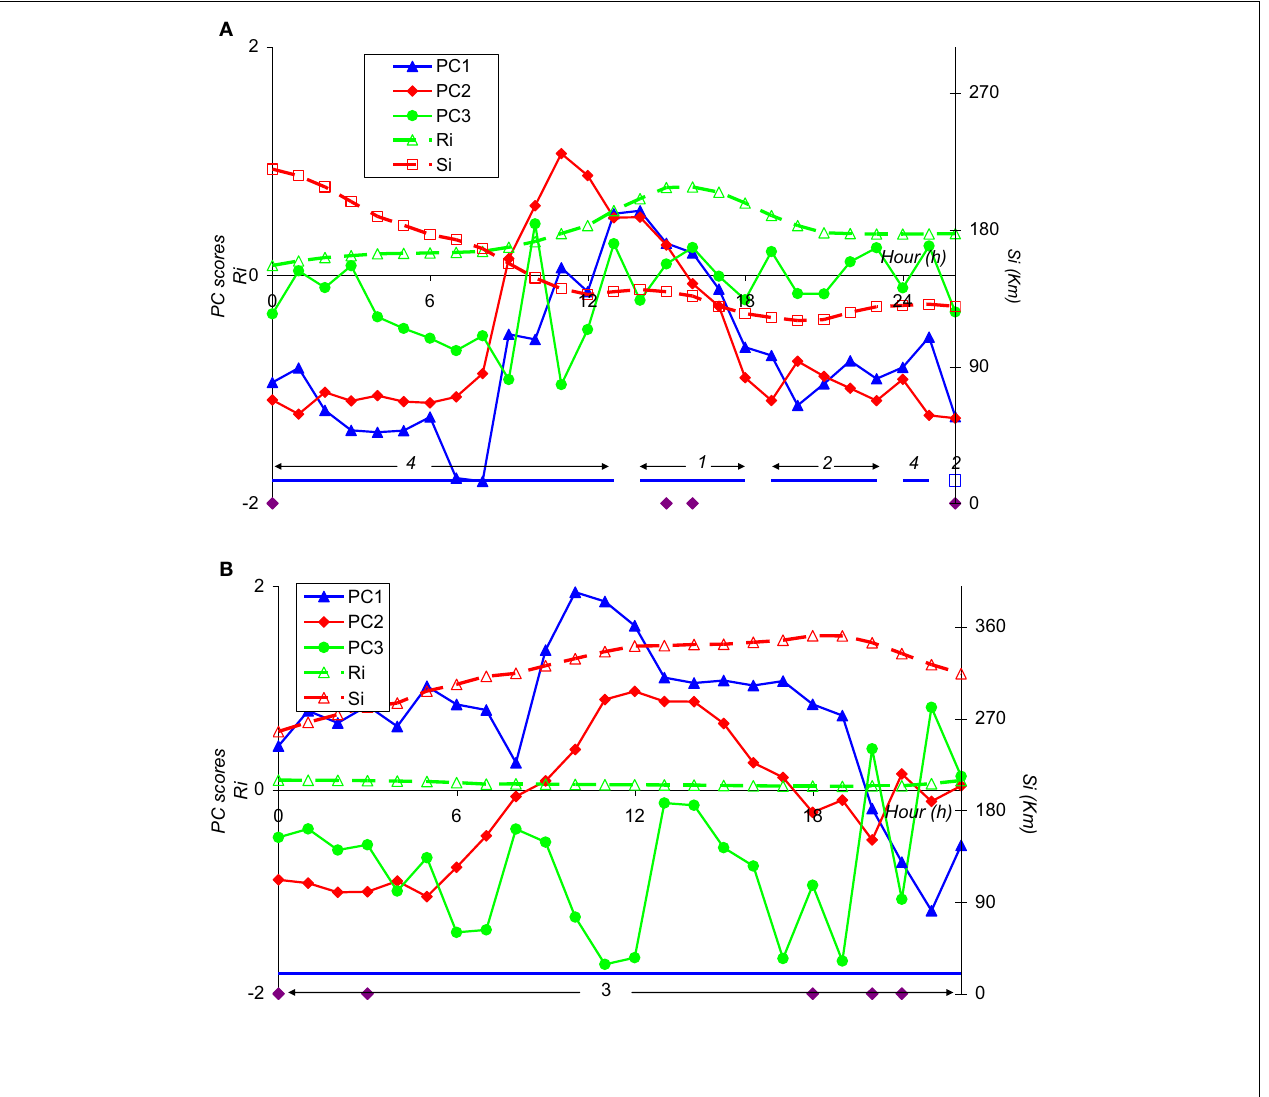
FIGURE 5 | Time series of Principal Component scores and the main Integral quantities during (A) 0:00 14/2–2:00 15/2, and (B) 10/3. PC1–PC3 are denoted with continuous blue lines with triangles, and red lines with diamonds respectively, and wind run (Si) and recirculation factor (Ri) with